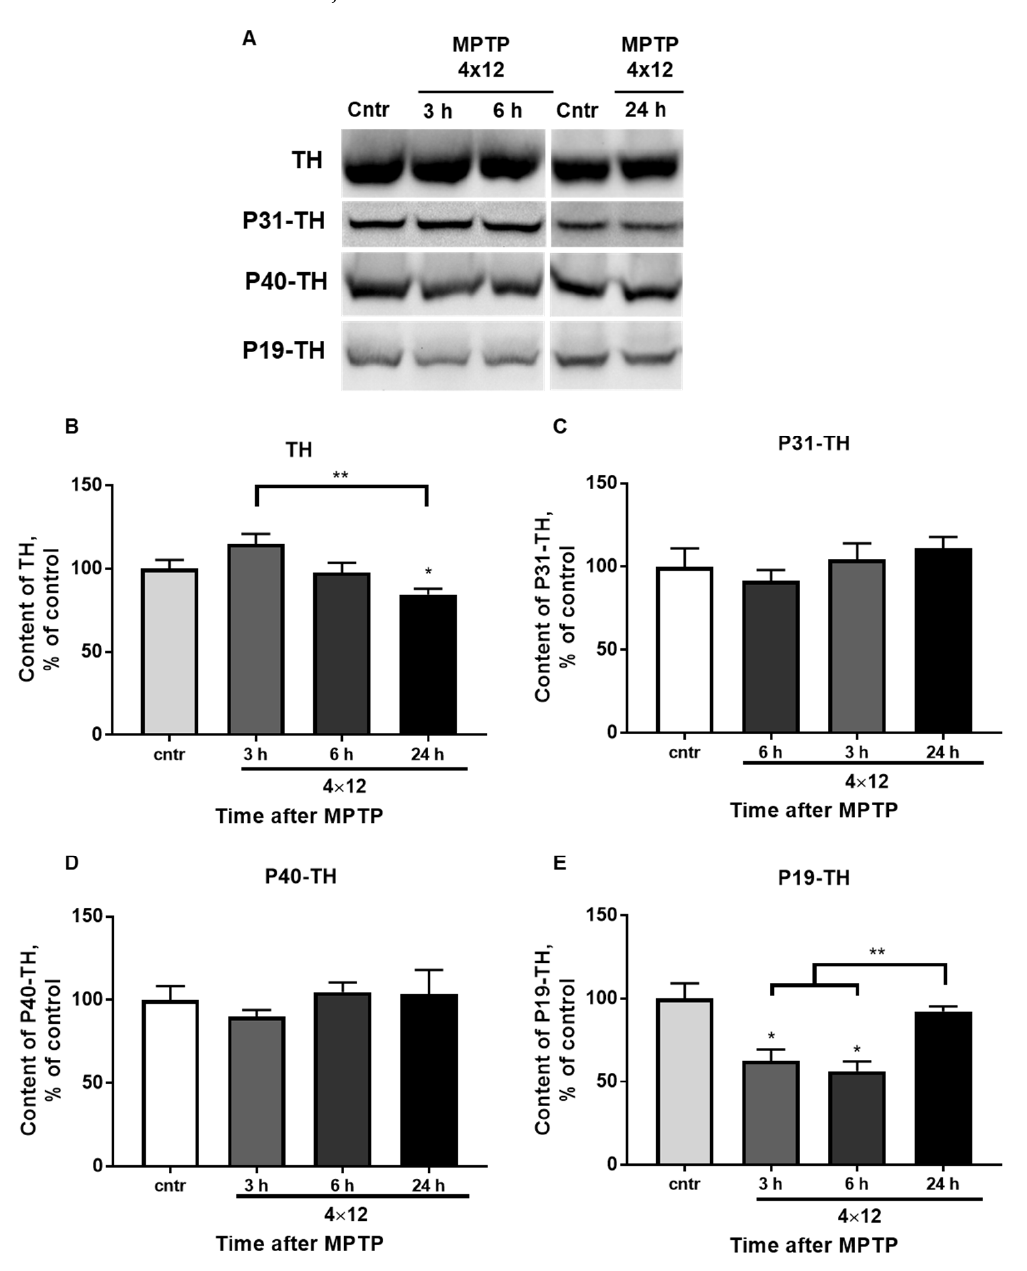
Figure 6. ( A ) Western blot representation of TH, P31-TH, P40-TH, and P19-TH immunoreactivity in the SN of the control and 3, 6, and 24 h after 4 × 12 mg/kg of MPTP. ( B – E ) Bar graph representation of TH ( B ), P31-TH ( C ), P40-TH ( D ), and P19-TH ( E ) in the SN of the control (saline) and 3, 6, and 24 h after 4 × 12 mg/kg of MPTP. The results are presented as percentages of those in the control (100%). * p < 0.05 compared with the control (saline). ** p < 0.05 compared with selected MPTP groups. The content of P31-TH and P40-TH (Figure 6A,C,D) did not change in the studied intervals after MPTP